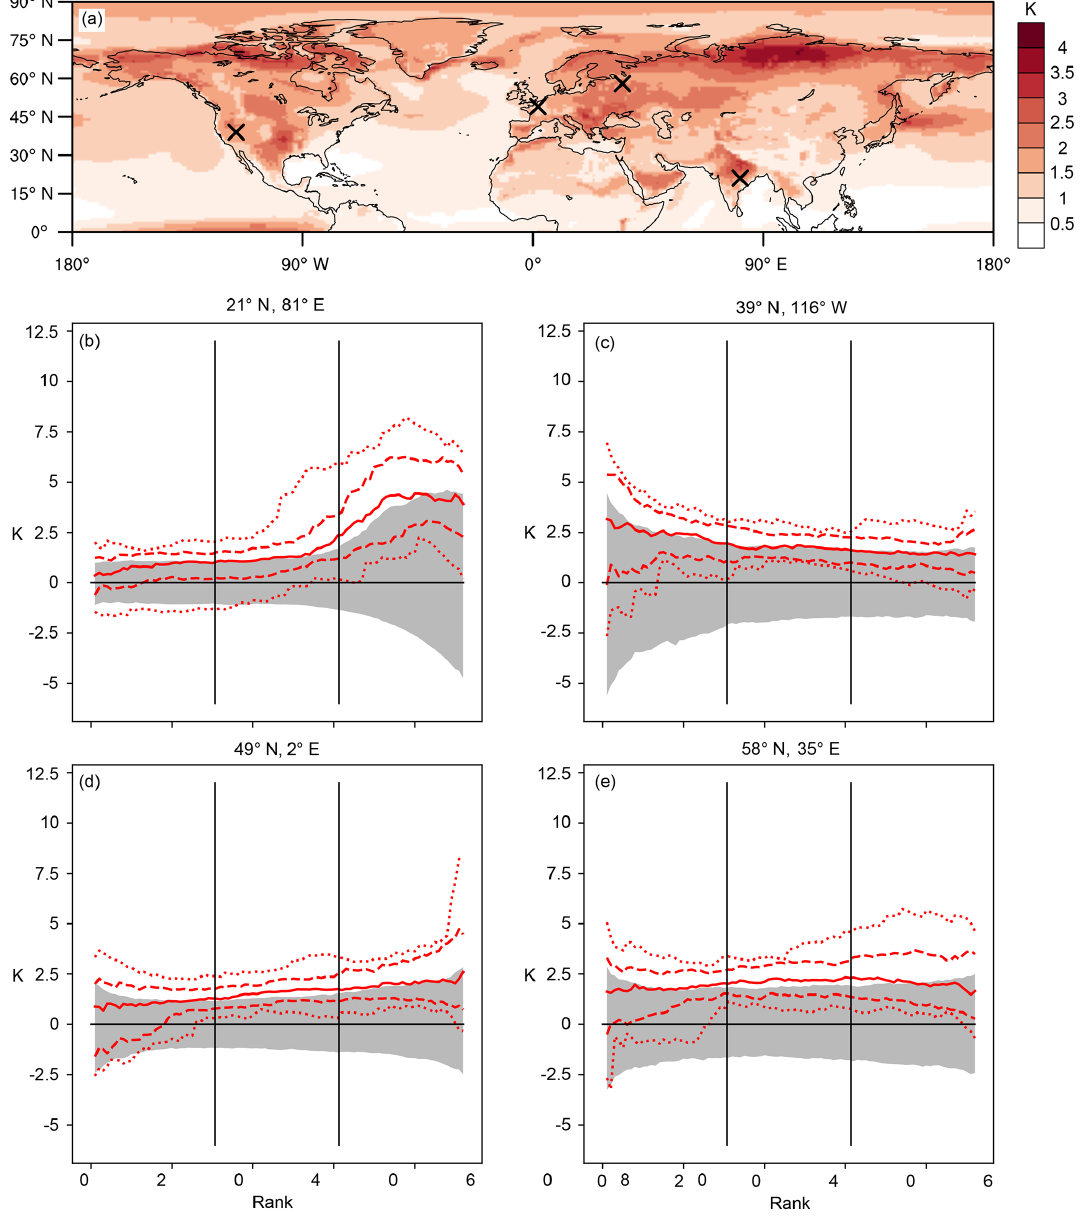
Figure 4. Extreme-summer T2m anomaly and extreme-summer substructure for selected grid points in CESM. Panel (a) displays XA CESM , and panels (b) – (e) show in red the maximum and minimum (dotted) 90th and 10th percentile (dashed) and the median (solid red) RDA CESM of the 35 CESM extreme summers. The 5th- to 95th-percentile range of the RDA CESM panel (a) indicate the grid points for which the rank day anomalies are shown in panels (b) – (e)